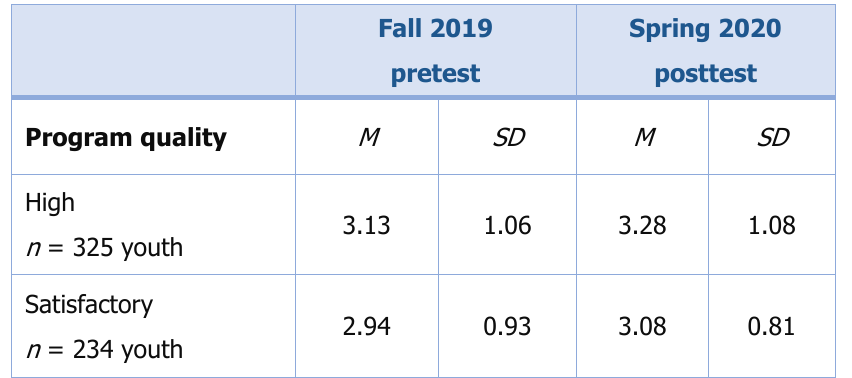
Table 4. Youth SEL Ratings at High-Quality and Satisfactory-Quality Programs